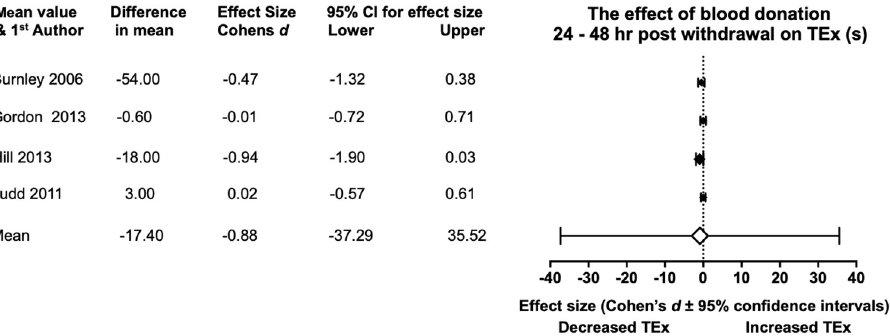
Fig 4. Statistical results from four studies of pre and 24–48 hr post BD in TEx (s). With the diamonds reflecting the effect size of the studies. The white diamond shows the overall mean effect size. All effect sizes are Cohen’s d and 95% confidence interval, with heterogeneity of I 2 = 11.57%.